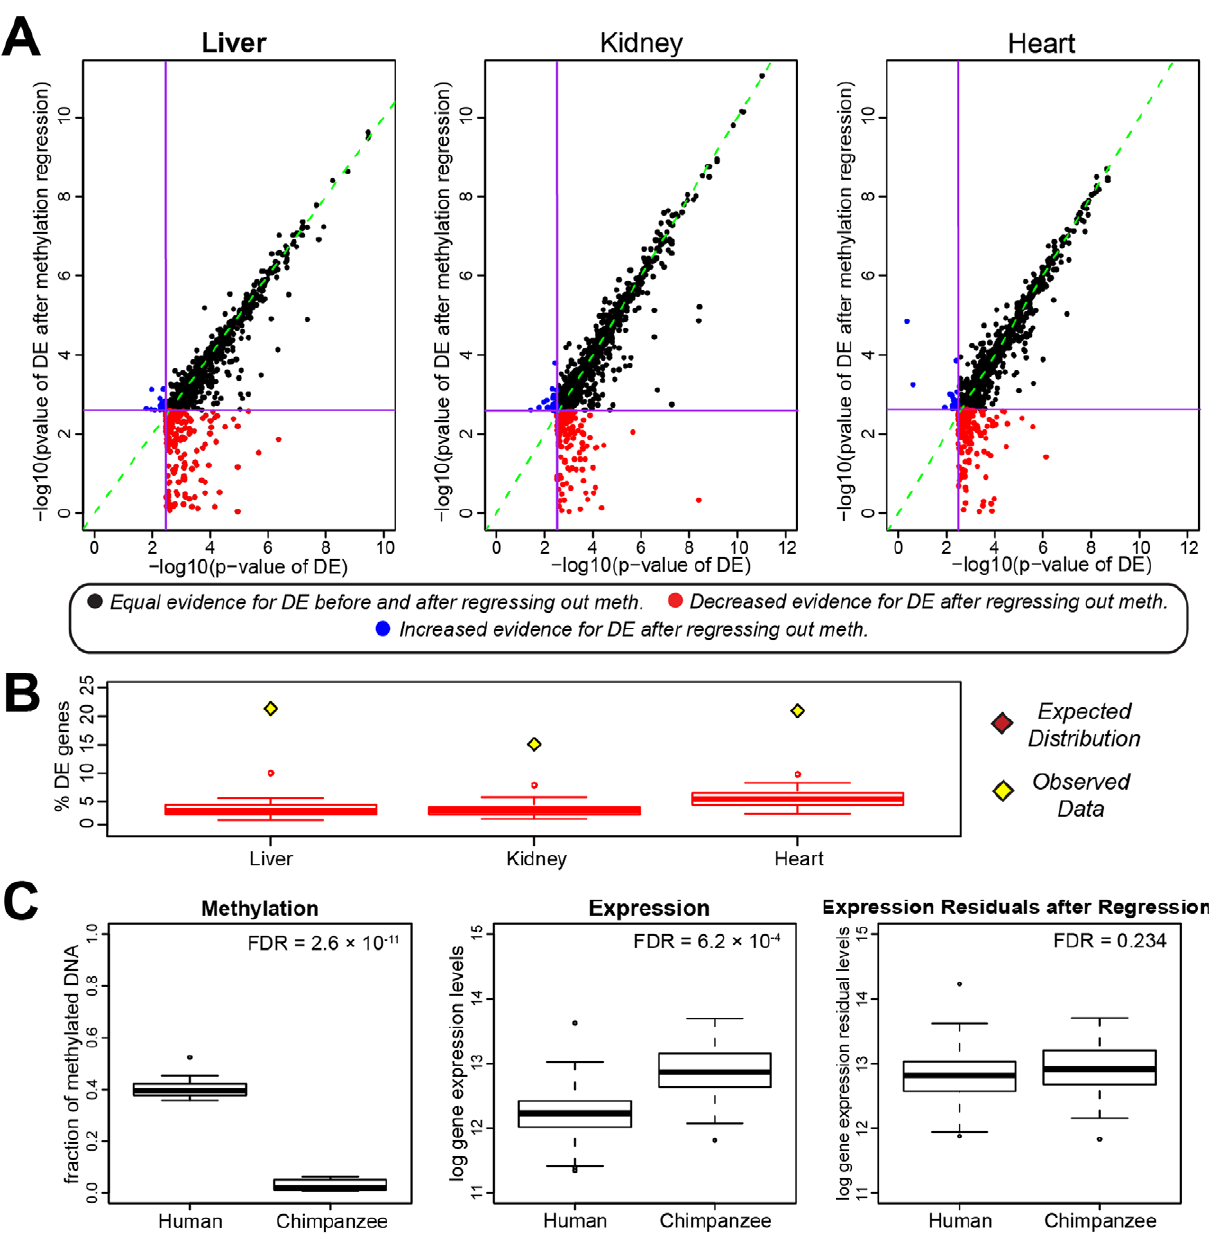
Figure 4. Inter-species methylation and gene expression differences. (A) Scatter-plots of the p-values obtained by testing the null hypothesis of no differences in gene expression levels between human and chimpanzee before (x-axis) and after (y-axis) regressing out methylation levels. The solid purple lines correspond to a 1% FDR threshold. (B) Boxplots of the distributions, based on 1000 permutations, of the percentage of genes for which the evidence for inter-species differences in gene expression levels is expected to be reduced following the correction for methylation levels, by chance alone. Yellow points indicate the percentages seen in the actual data. (C) A representative example of the ZBTB80S gene, which is associated with inter-species promoter methylation differences in the kidney. In the left and middle panels are the human and chimpanzee methylation b -values and normalized gene expression levels, respectively. In the right panel are the normalized gene expression levels for ZBTB80S , after correcting for the methylation b -values.